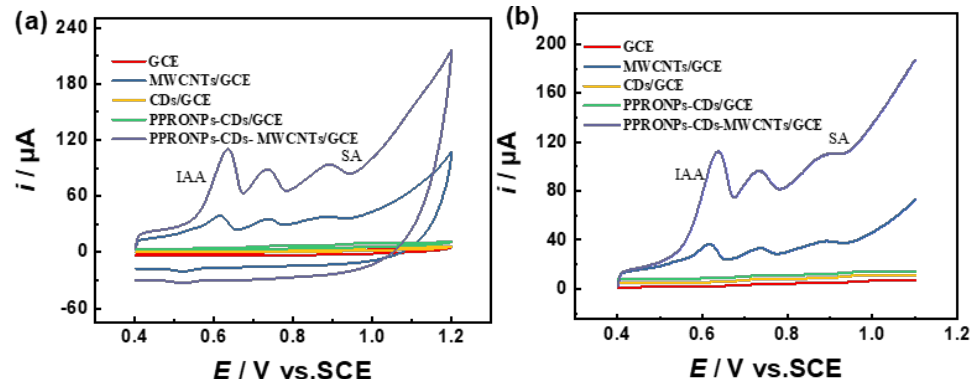
Figure 5. CV ( a ) and LSV ( b ) of GCE, CDs/GCE, PPRONPs − CDs/GCE, MWCNTs/GCE, and PPRONPs − CDs − MWCNTs/GCE modified electrodes in 0.1 M PBS (Ph = 7) containing 50 μM IAA and 50 μM SA. Scan rate of 100 mV/s.